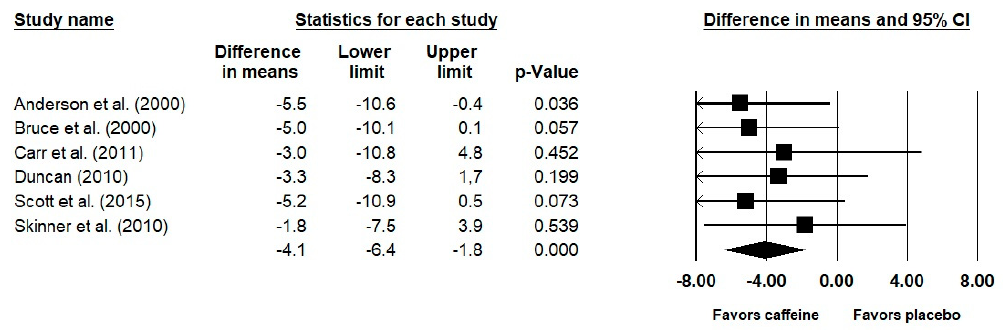
Figure 2. Results of the meta-analysis. Values are expressed as a difference in means and 95% confidence interval (95% CI). The size of the squares reflects the statistical weight of each study. Negative values denote improvements in performance, that is, a reduction in the time needed to complete the rowing distance.